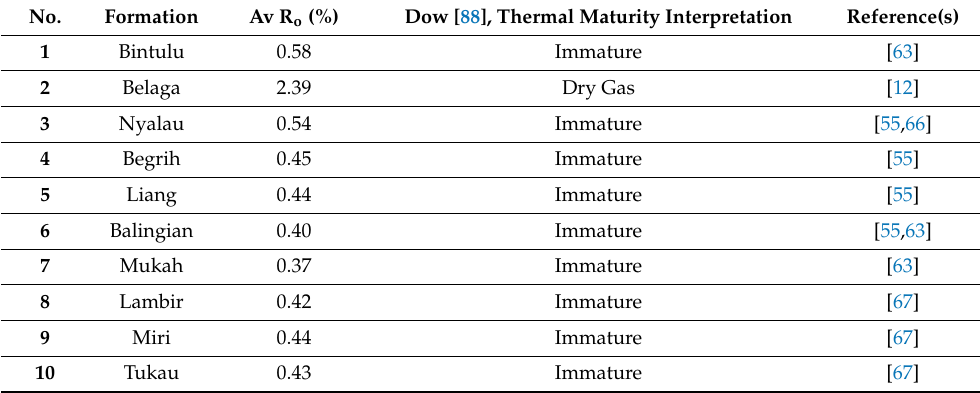
Table 15. Thermal maturity interpretation for formations in Sarawak according to Dow [88] using R o